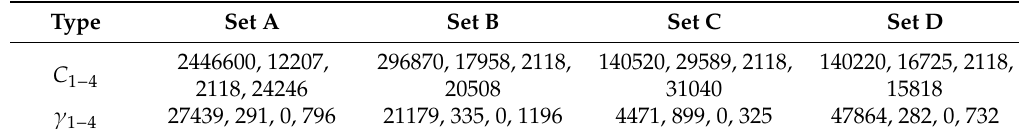
Table 4. PSO method—Calibration for Set A, Set B, Set C and Set D.